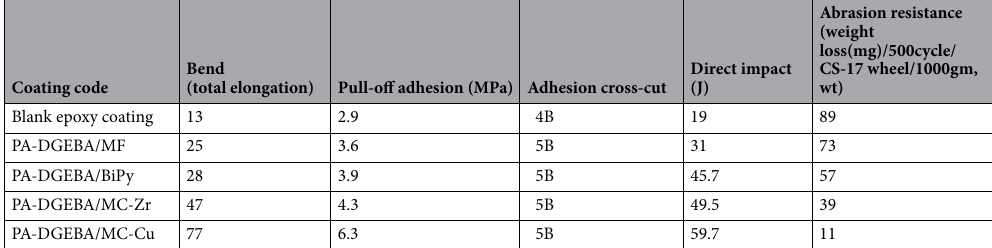
Table 9. Mechanical performance properties of conventional unmodified epoxy and modified MF, Bipy, Zr(IV), and Cu(II) epoxy coated films.